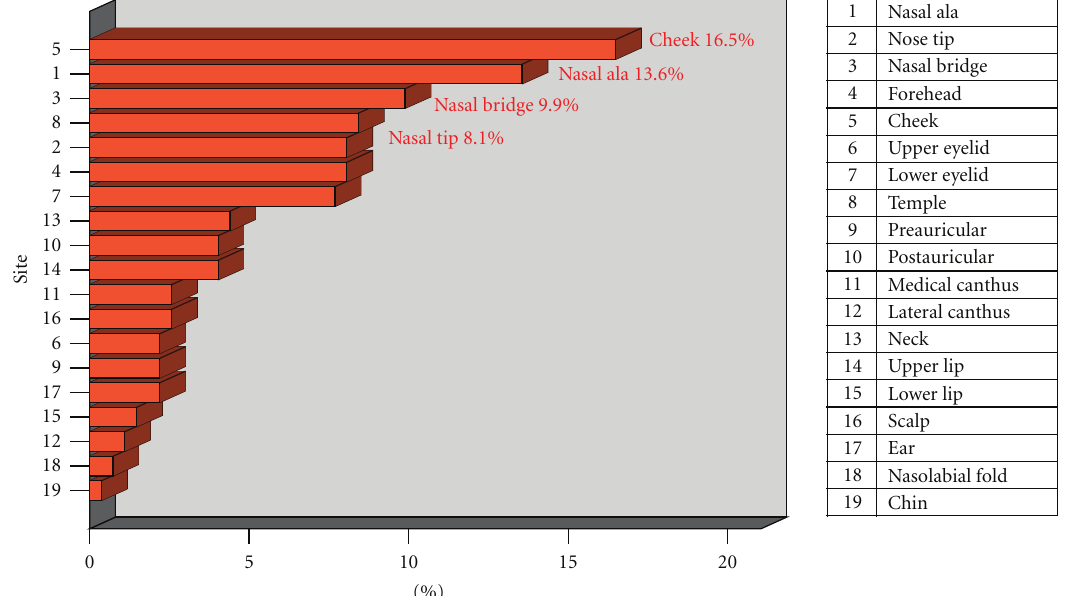
Figure 2: HNBCC presentation—anatomical sites. The commonest site was on the nose.